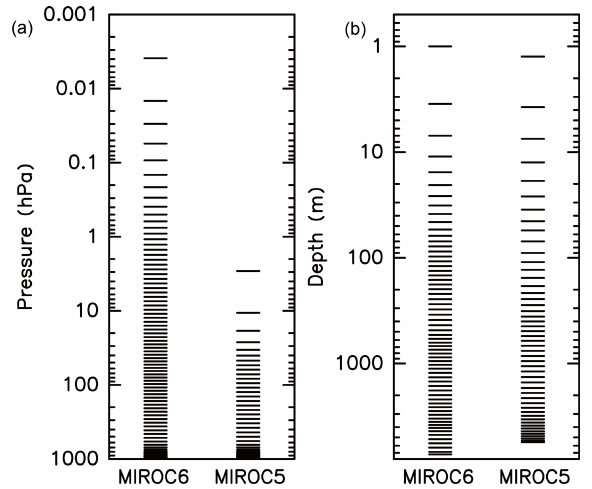
Figure 1. Vertical half-levels for the atmospheric (a) and the oceanic (b) components of MIROC6 and